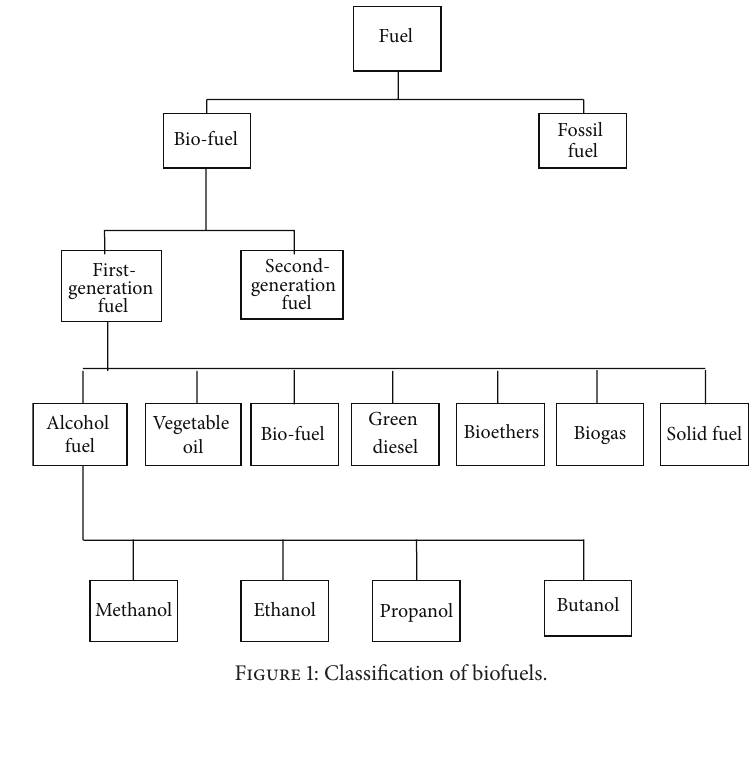
Figure 1: Classification of biofuels.